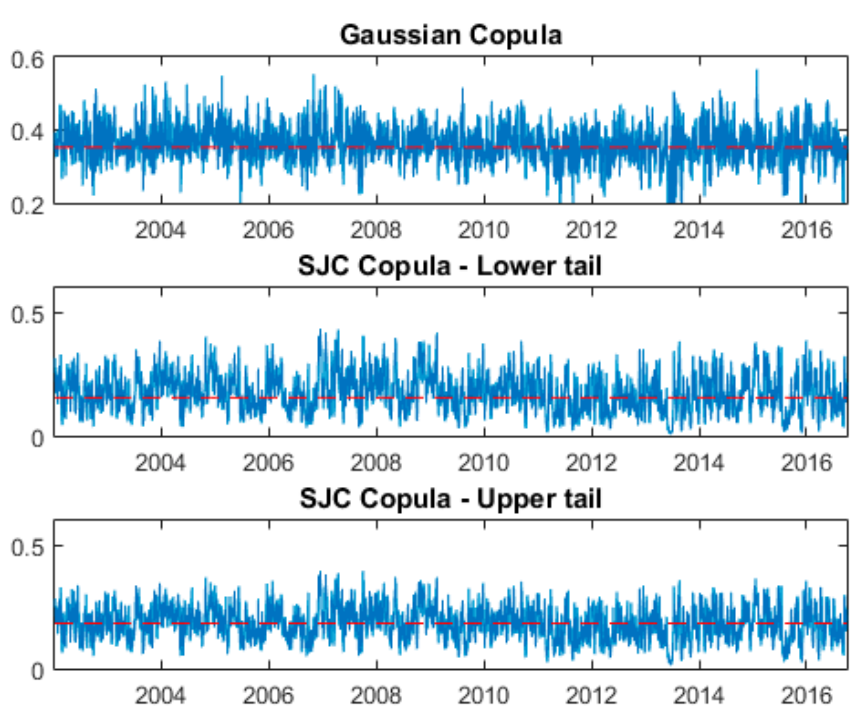
Figure 8. Dependence path of the time-varying copula for PM 10 –SO 2 .